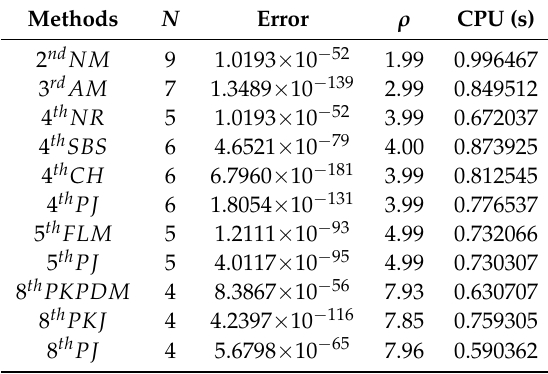
Table 5. Comparison of results for Application 2.